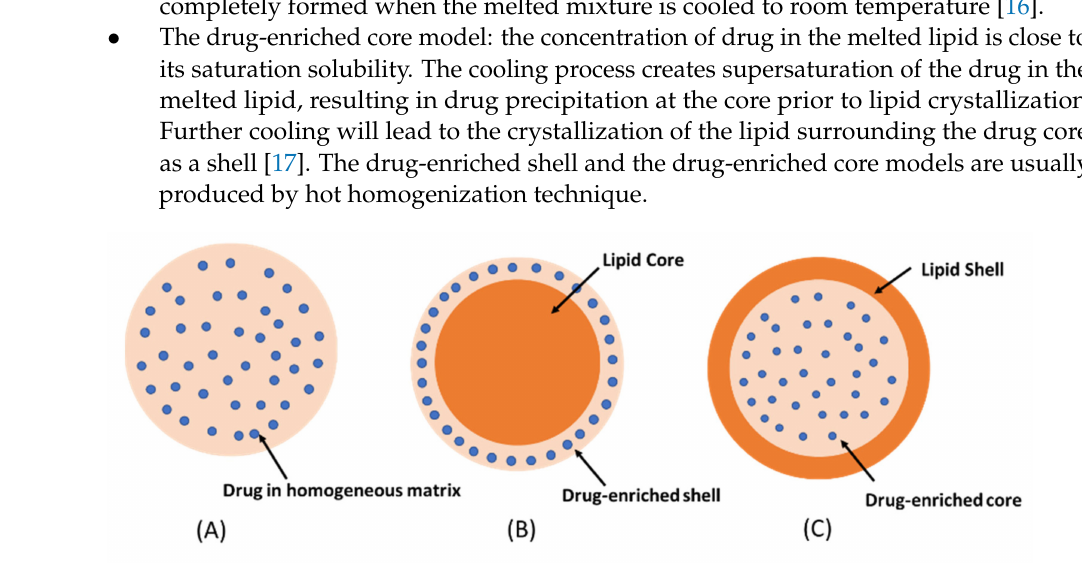
Figure 1. The drug incorporation models of SLNs ( A ) homogeneous matrix, ( B ) drug-enriched shell, ( C ) drug-enriched